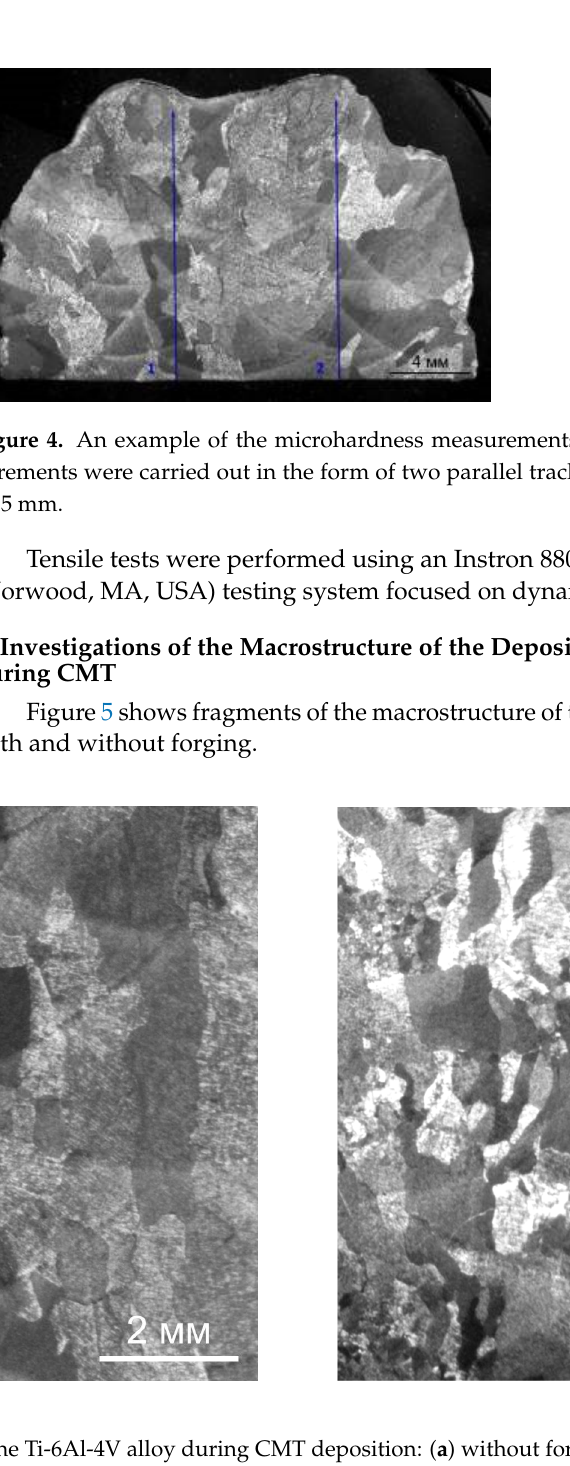
( a ) ( b ) Figure 6. Macrostructure of the Ti-6Al-4V alloy during CMT deposition with heat treatment: ( a ) without forging, ( b ) with interpass forging. 4. Microstructure Analysis of the Deposited Layers of the Ti-6Al-4V Alloy during CMT Deposition A typical structure of the titanium alloy of the Ti-Al-V system is observed: a small amount of the initial β -grain (a body-centered cubic β -phase; in fact, it is guessed only from thin interlayers along the grain boundaries), a lamellar α -phase (hexagonal close- packed α -phase), and coarsely acicular α′ -martensite. For a more detailed analysis of the microstructure of the deposited wall, the following sections were investigated at different magnifications, i.e., the boundary between the primary β -grains and the boundary be- tween the deposited layers and the intragranular structure.